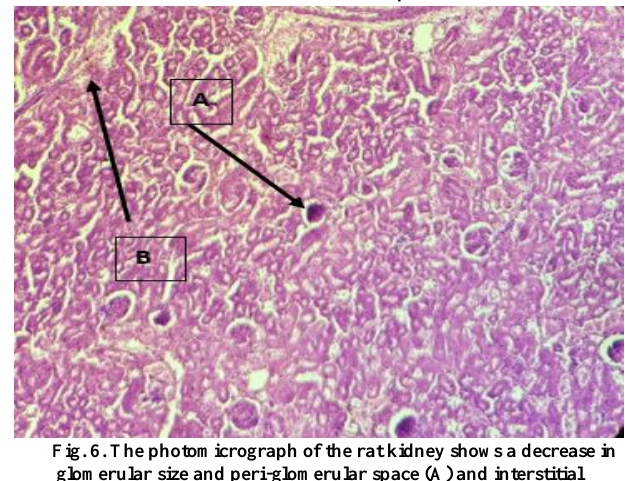
Fig. 3. Photomicrograph of rat liver showing dilated and congested portal vein (A) and inflammatory infiltrates (B) [ARS 50 group 100X].